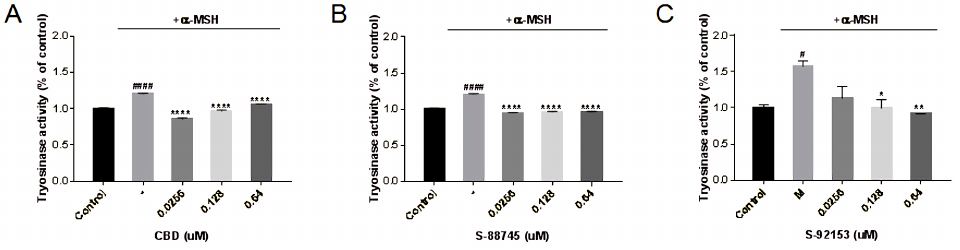
Figure 17. Inhibition of ( A ) CBD, ( B ) S-88745 and ( C ) S-92153 on α -MSH-induced tyrosinase activity in B16F10. The control group was not stimulated by α -MSH. The α -MSH -treated group (-) was stimulated by α -MSH to produce pigmentation. The experiments were repeated three times. Each bar illustrates the average ± standard deviation (SD) counted from three experiments. p < 0.05 was considered statistically significant. * p < 0.05 compared to the α -MSH − treated group; ** p < 0.01 compared to the α‐ MSH − treated group; **** p < 0.0001 compared to the α‐ MSH − treated group; # p < 0.05 compared to the control group; #### p < 0.0001 compared to the control group.